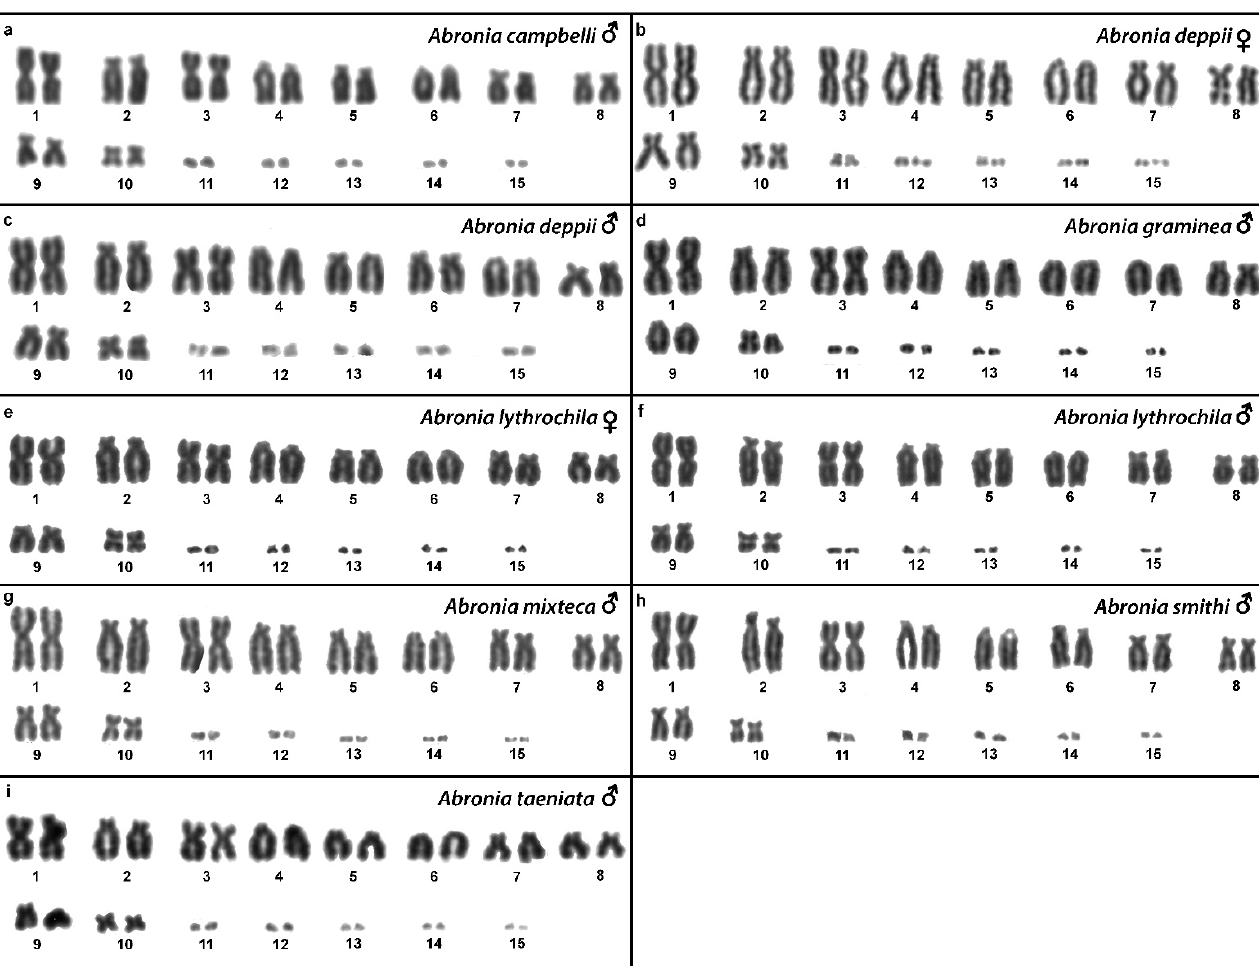
Figure 1. Giemsa-stained karyograms of Abronia campbelli ( a ), Abronia deppii ( b , c ), Abronia graminea ( d ), Abronia lythrochila ( e , f ), Abronia mixteca ( g ), Abronia smithi ( h ) and Abronia taeniata ( i ).